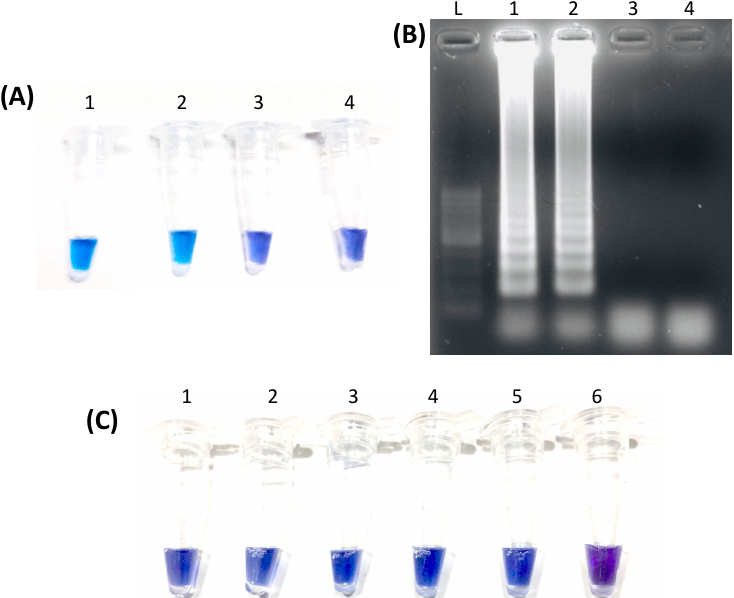
Figure 1. Representative results of LAMP assay targeting E. canis gltA by direct visualization and after gel electrophoresis. ( A ) shows the results of selected samples under the established optimal condition through direct visualization wherein Tubes 1 and 2 show a blue color indicative of a positive reaction. In contrast, Tube 3 shows a violet color indicative of a negative reaction similar to the negative control (Tube 4). In ( B ), the same samples were subjected to gel electrophoresis and viewed over a UV transilluminator. Lanes 1 and 2 display multiple bands with a ladder-like appearance, similar to the DNA marker (L), whereas Lane 3 shows the absence of bands, similar to the negative control in Lane 4. ( C ) shows the test results for the detection limit using a purified PCR amplicon of E. canis gltA that was serially diluted 10-fold. Tube 1 has the highest number of template copies at 7.41 × 10 9 while tube 5 has the lowest with 7.41 × 10 4 copies. Tube 6 is the negative